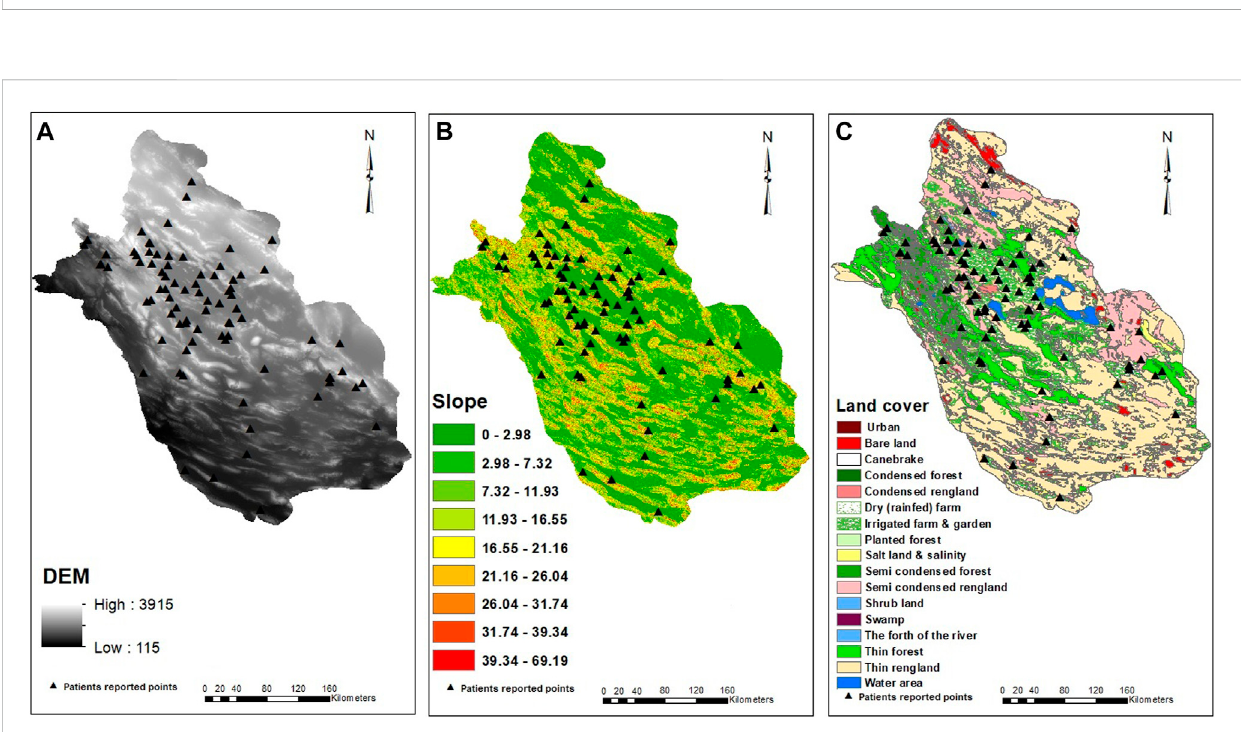
FIGURE 5 Patient distributions (triangle symbol) among areas with varied elevation (A) , slope (B) , and land covers (C)